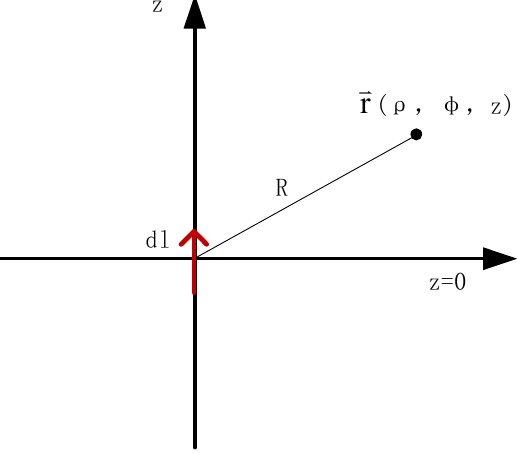
Figure 10. Negative corona discharge dipole radiation model.